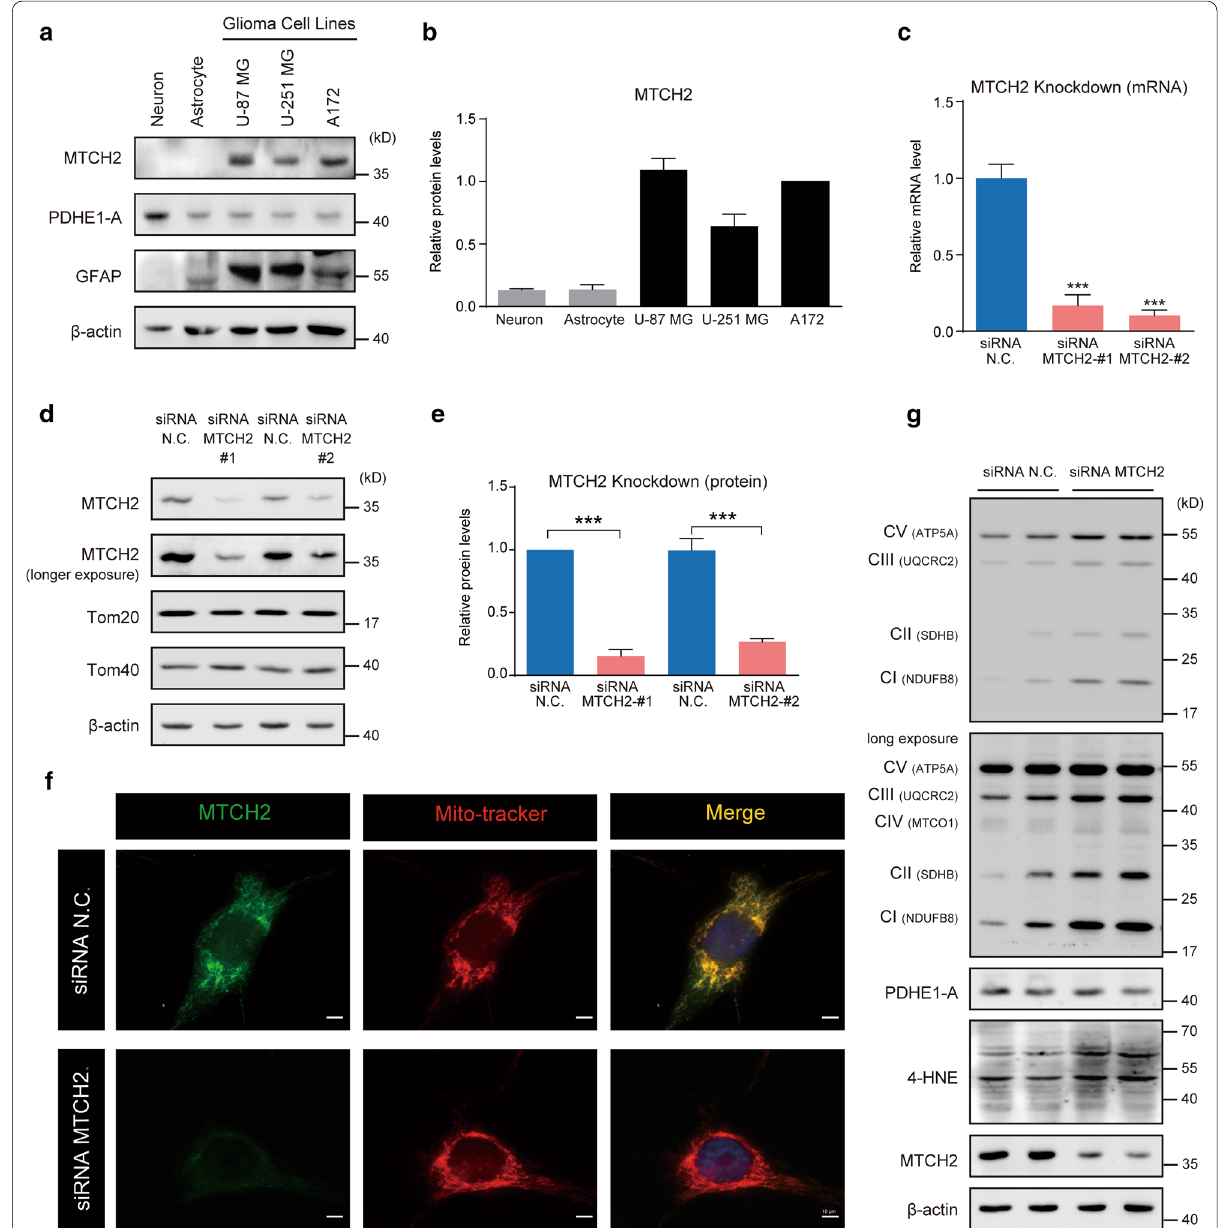
Fig. 3 High expression of MTCH2 in glioma cells may increase mitochondrial OXPHOs. a , b Western blots and quantifications showing the enriched expression of MTCH2 in glioma cells compared to primary neurons and astrocytes. c qPCR results showing the decreased mRNA level of MTCH2 in A172 cells by siRNA-mediated knockdown (N 3). d , e Western blots and quantifications showing the decreased protein level of MTCH2 in A172 = cells by siRNA-mediated knockdown. Noted that other mitochondrial outer membrane proteins Tom20 and Tom40 were not affected by MTCH2 knockdown. f Immunostaining images showing the mitochondrial localization of MTCH2 in A172 cells. Noted that MTCH2 signals were dramatically decreased by siRNA-mediated knockdown. Scale bar, 10 μm. g Western blots showing the increased mitochondrial respiratory proteins and 4-HNE levels by MTCH2 knockdown in A172